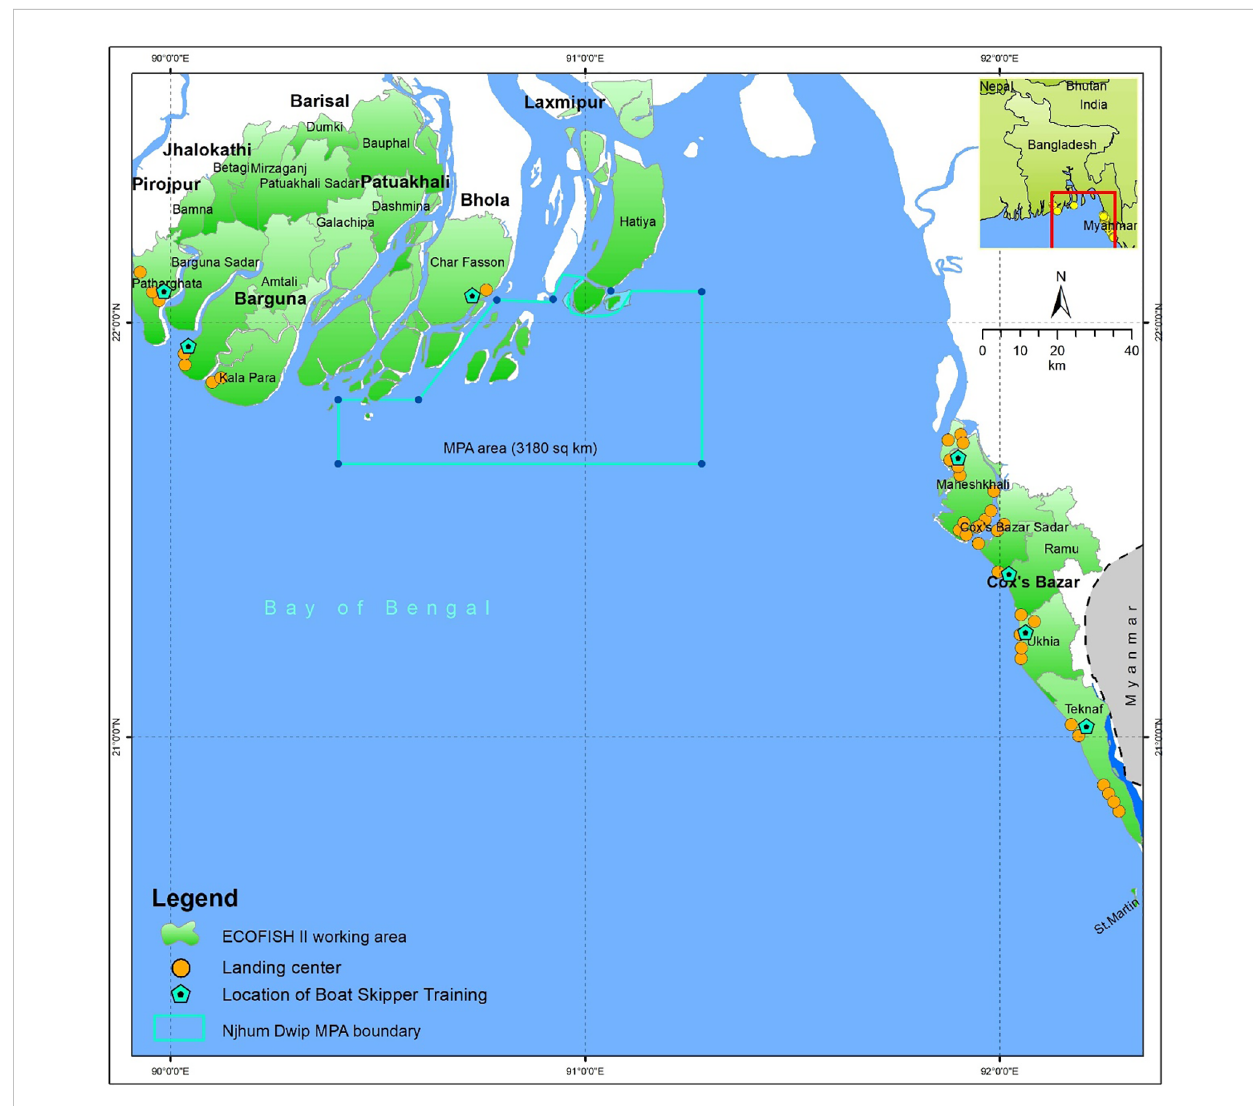
FIGURE 1 Map of the study area showing the locations of the landing stations from where artisanal fi sheries